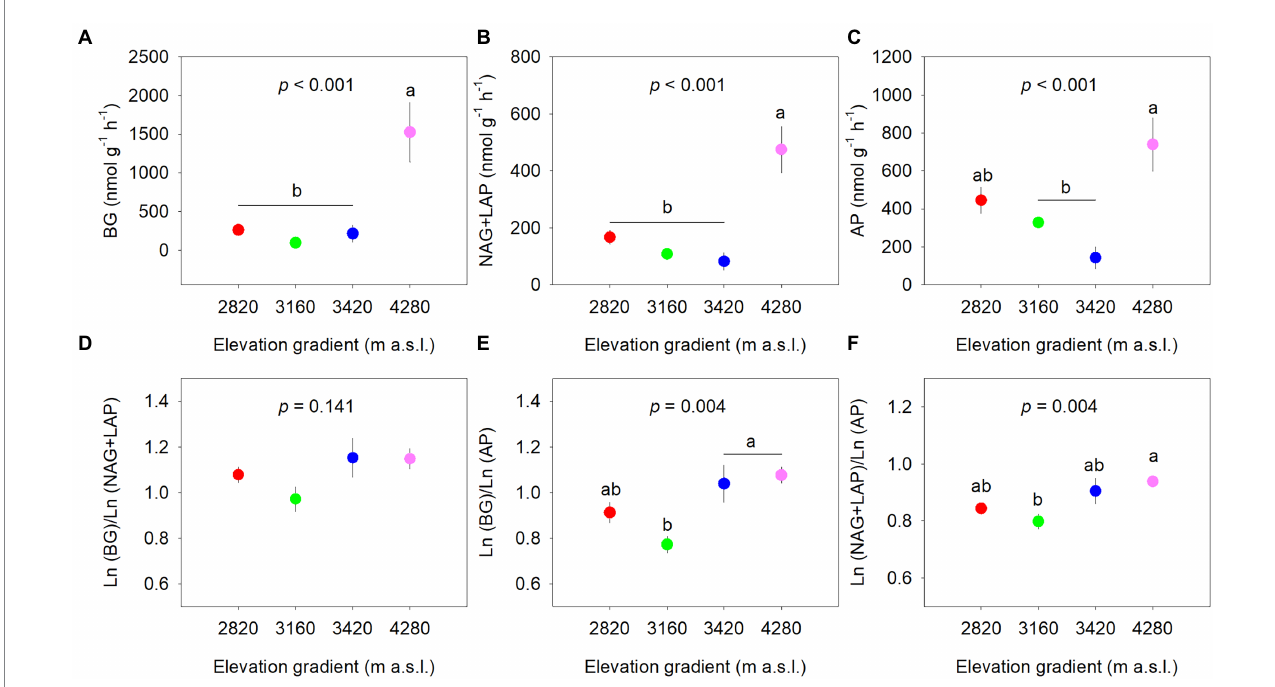
FIGURE 2 Elevational patterns of soil extracellular enzyme activity normalized by soil (A–C) and soil enzymatic acquisition ratio (D–F) . Data are expressed as the mean ± standard error. Different letters indicate significant difference ( p < 0.05) among elevations. BG, β -glucosidase; NAG, β -N-acetylglucosaminidase; LAP, leucine aminopeptidase; AP, acid